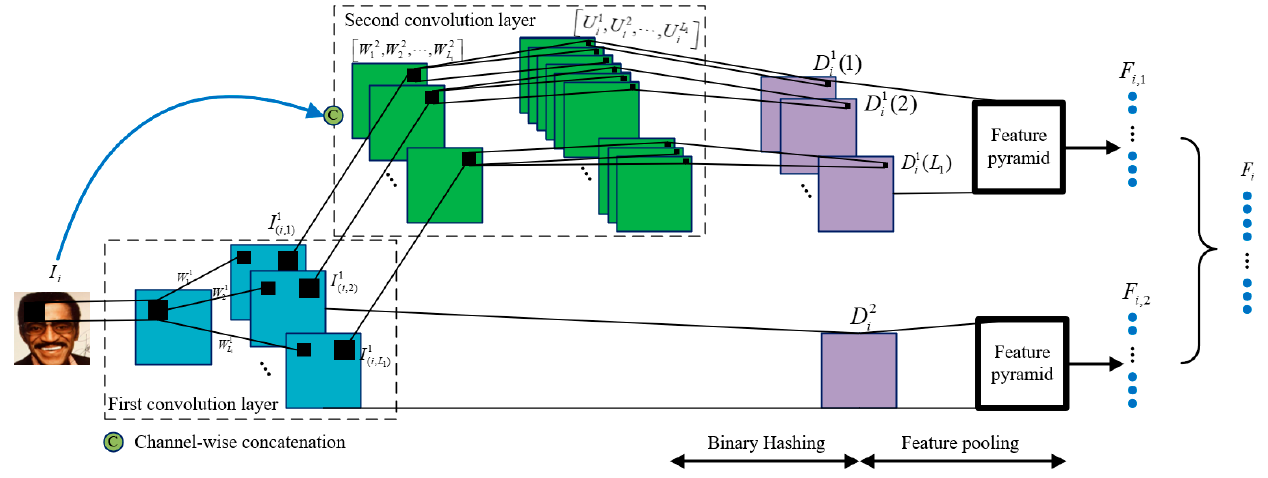
Figure 2. The block diagram of the proposed MMPCANet.